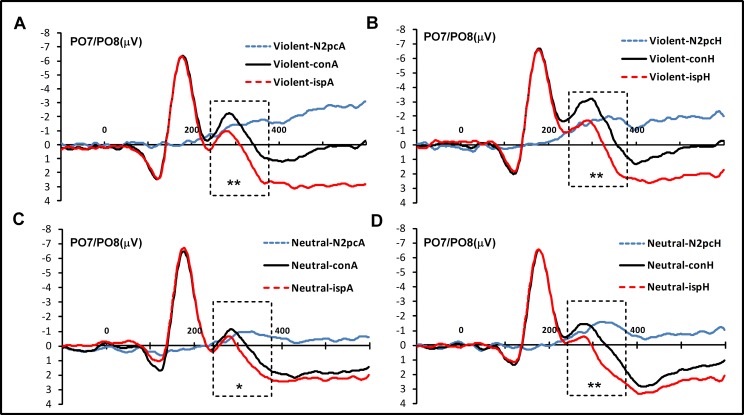
The N2pc for task A.(A) It represent the grand averages of N2pc in the violent video game group in response to angry faces. (B) It represent the grand averages of N2pc in the violent video game group in response to happy faces. (C) It represent the grand averages of N2pc in the neutral video game group in response to angry faces. (D) It represent the grand averages of N2pc in the neutral video game group in response to happy faces. *p < .05, **p < .01.